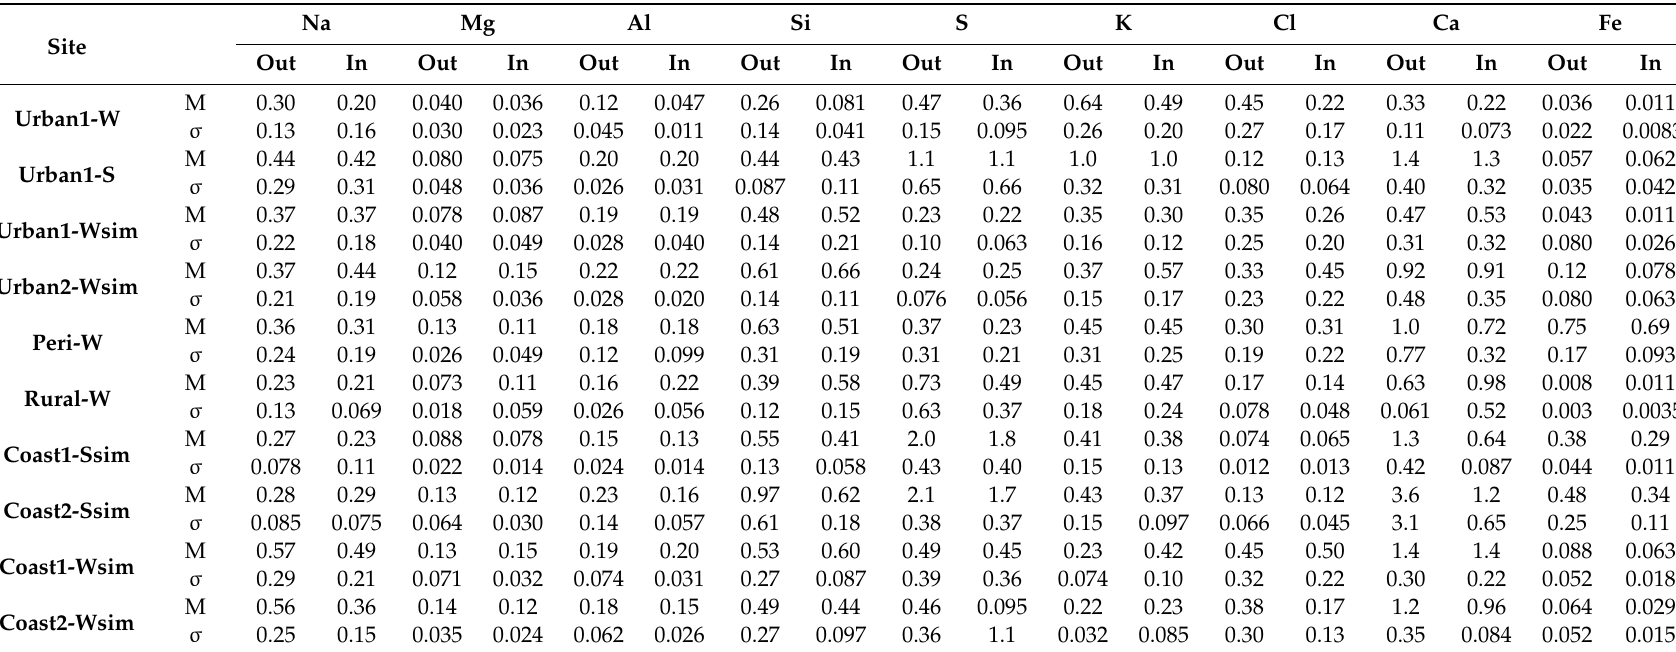
Table 4. Average mass concentrations (M) and standard deviations ( σ ) (in µ g / m 3 ) of the macro-elements measured outdoors and